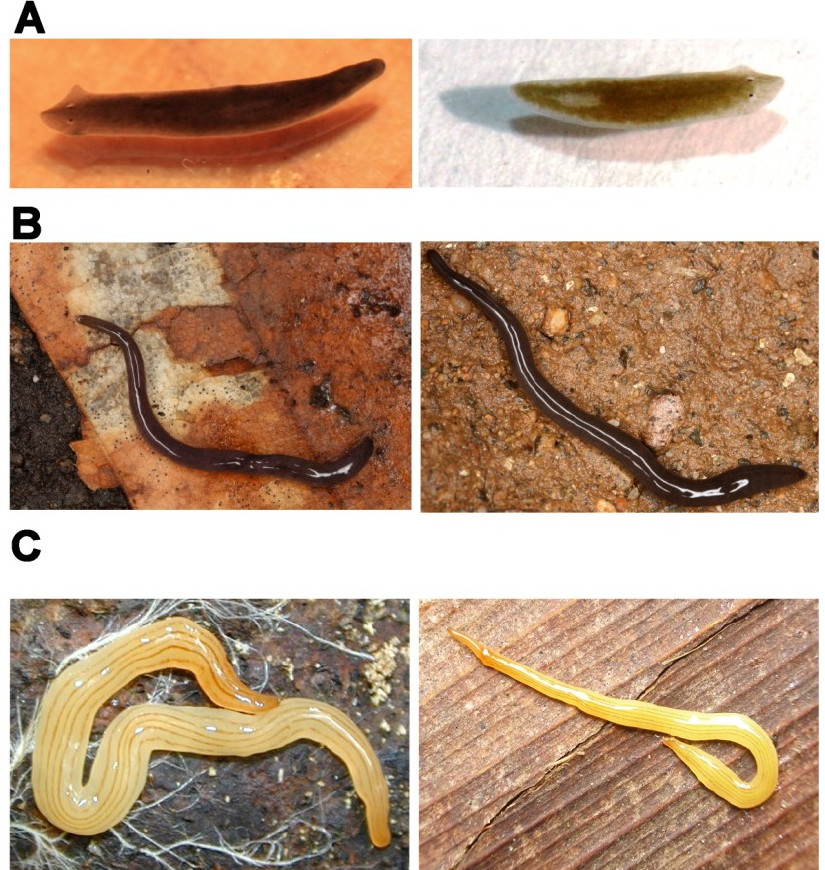
Figure 2. ( A ) Left D. sicula , right D. subtentaculata ; ( B ) Two different morphotypes of Microplana ; ( C ) Left Luteostriata ernesti; right L.caissara